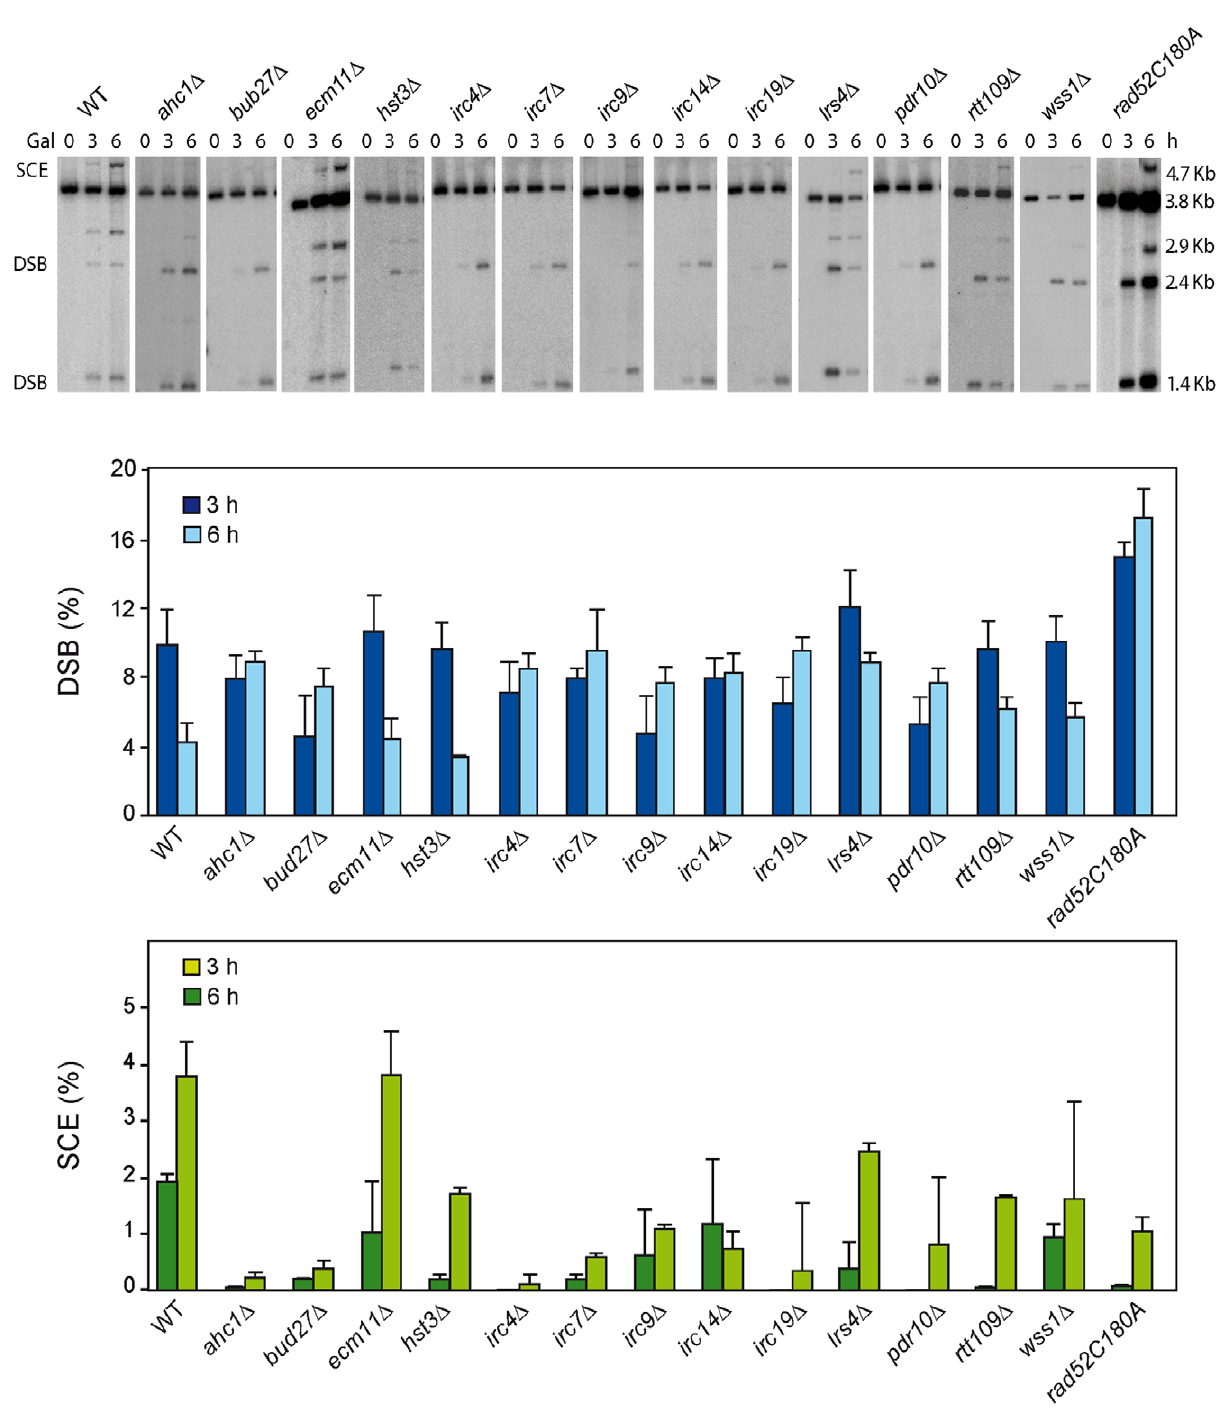
Figure 2. Molecular analysis of SCR in 13 SCR–defective mutants. Kinetic analysis of SCR in 14 mutants (WS strains isogenic to W303) pre- selected as SCR-defective candidates. Representative genomic blots and quantification of HO-induced DSBs (upper panel) and SCE recombination (lower panel) are shown. Average and standard deviations of three samples from each genotype are plotted. The hst3 D mutation is strongly affected in intrachromosomal decrease) that contrasts with an enhancement of recombination in SCR repeat recombination (50-fold decrease) and weakly in the plasmid-chromosome system (2-fold). Further confirmation of plasmid-chromosome recombination (11-fold decrease) while the this specific SCR defect was obtained with the previously reported rtt109 D effect is not as pronounced in both systems. On the other his3 D 5 9 -his3 D 3 9 chromosomal repeat system for the genetic hand, wss1 D shows a strong and specific defect in SCR (146-fold analysis of unequal SCR [23] in which spontaneous SCR was